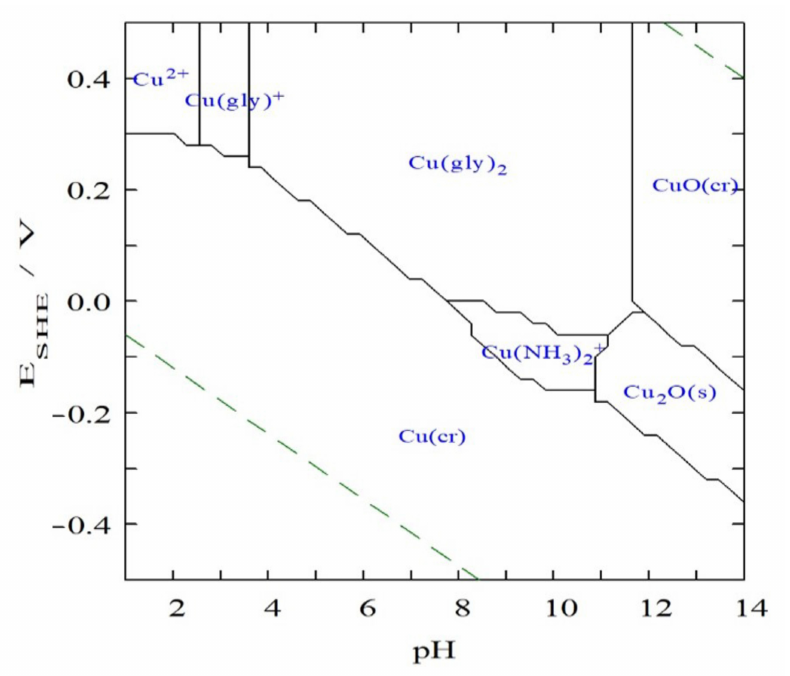
Figure 1. Eh-pH diagram of the copper–glycine–ammonia–H 2 O system at 25 ◦ C, copper concentration of 0.02 M, glycine concentration of 0.16 M and ammonia concentration of 0.5 M (made by Medusa- Hydra software, available at https://www.kth.se/che/medusa/, accessed on 30 August 2022). Table 3. Cumulative formation constants of selected complexes between metal and glycine or ammonia at 20–25 ◦ C (M stands for Cu ion, and L stands for glycine or ammonia (ammine) ligand); data taken from